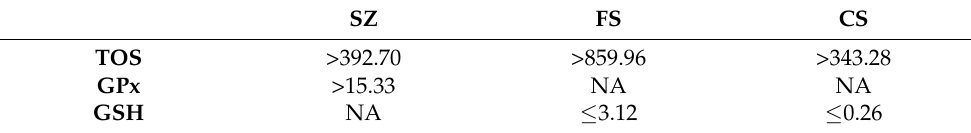
Table 2. Cut-off point for proposed redox